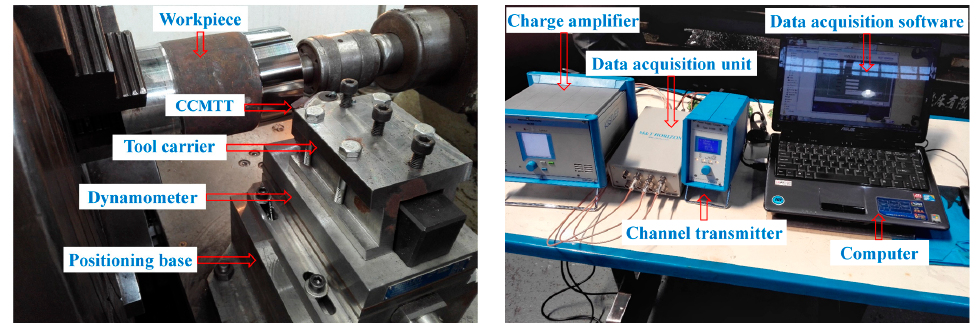
Figure 8. Test platform of cutting force collection. Table 1. Geometric angles of the tool.